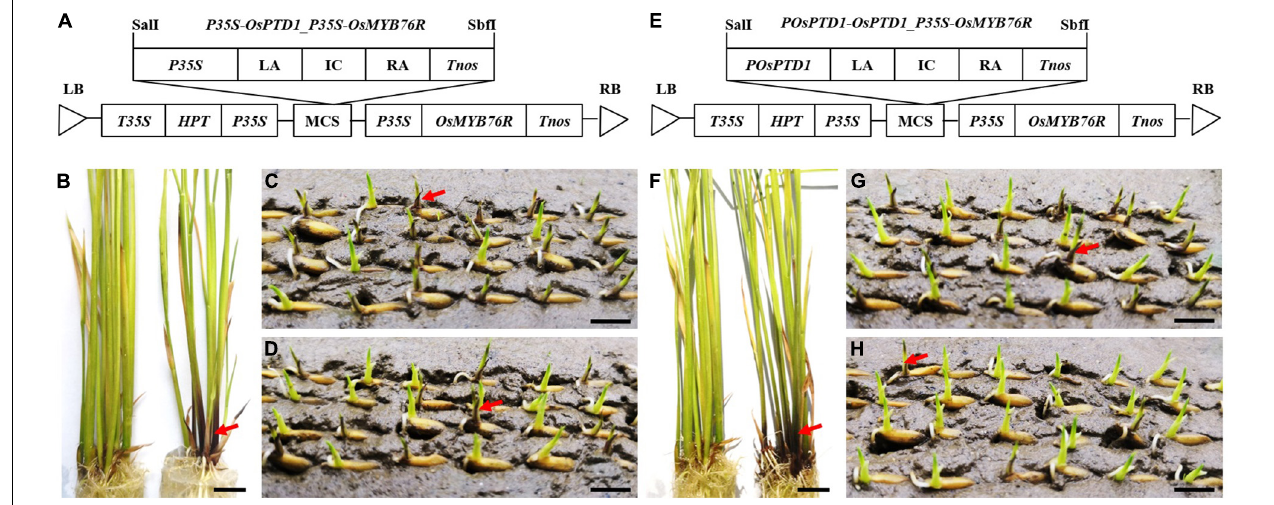
FIGURE 3 | Inheritance characteristics of OsPTD1 RNAi. Panels (A,E) depict the structure of the RNAi vectors pP35S-OsPTD1 _ P35S - OsMYB76R and pPOsPTD1 - OsPTD1 _ P35S - OsMYB76R , respectively. Panels (B–D) show a T 0 -positive plant, and a T 1 and F 1 (positive plants as the male parents) of P35S-OsPTD1 _ P35S-OsMYB76R . Panels (F–H) show the T 0 -positive plants and T 1 and F 1 (positive plants as the male parent) of POsPTD1-OsPTD1 _ P35S-OsMYB76R . Scale bars, 0.8